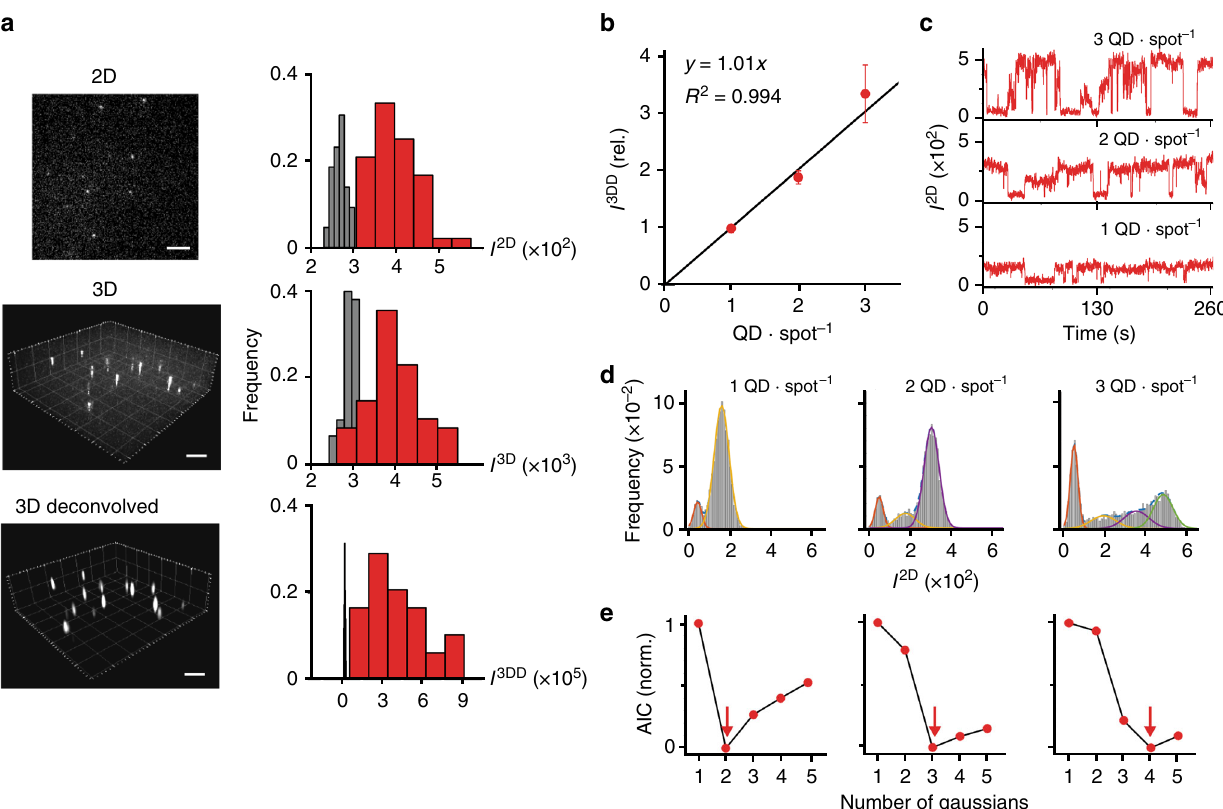
Fig. 3 Intensity calibration for counting growth factors. a Representative images show QD744 imaged in two-dimensional (2D), three-dimensional (3D), and 3D after deconvolution. Histograms depict noise (gray) and quantum dot (QD) intensities (red). Voxel sizes are 3 × 3 for 2D and 3 × 3 × 11 for both 3D and deconvolved 3D. N = 48. Scale bar, 5 µ m. b Intensity calibrated deconvolved 3D analysis of diffraction-limited spots containing 1, 2, or 3 QDs. Points indicate mean ± s.e.m. with N = 72, 216, and 27 spots for 1, 2, and 3 QD spot − 1 , respectively. The number of QDs per diffraction-limited spot is calculated from distributions of intensity from time traces based on the number of Gaussians fi tted to brightness histograms. The number of QDs per spot is the number of fi tted Gaussian minus 1 (noise) . c Examples of intensity time traces of 1, 2, and 3 QD spot − 1 . d Gaussian fi tting for intensity histograms of 1, 2, and 3 QD spot − 1 corresponding to examples shown in c . e Minima of Akaike information criteria (AIC) are indicated by red arrows, corresponding to the optimal number of Gaussians to fi t each intensity (Supplementary Figure 10) and at 4 °C (Fig. 4c, d and Supple- mentary Figure 8b), with <13% deviation in mean stimulation magnitude between theory and experiment (Supplementary